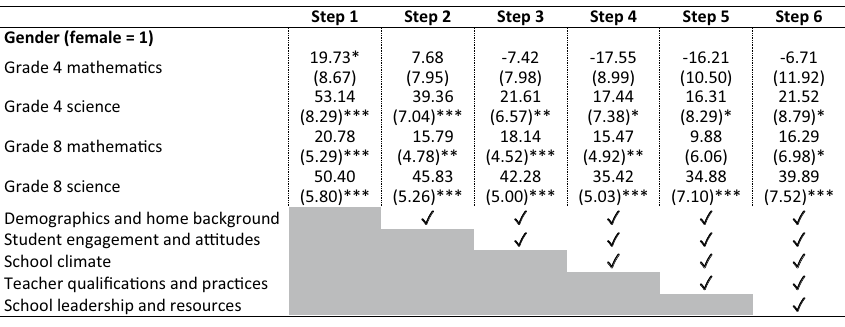
Table 9 Summary of main findings from the hierarchical two‑level linear regression